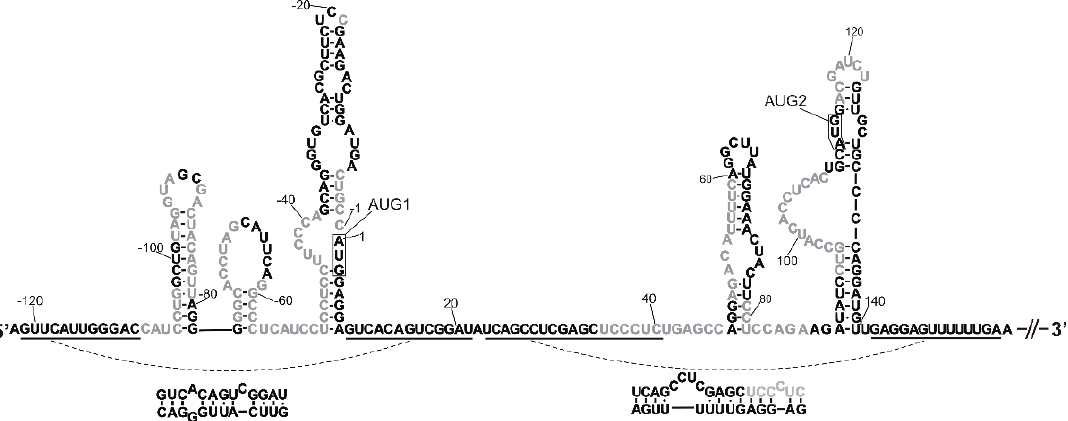
Figure 5. RNA accessibility mapping to oligonucleotide hybridization. Secondary structure model of the 5 ′ -terminal region of mouse p53 mRNA. Nucleotides where at least three oligonucleotides are predicted to bind are marked in grey.